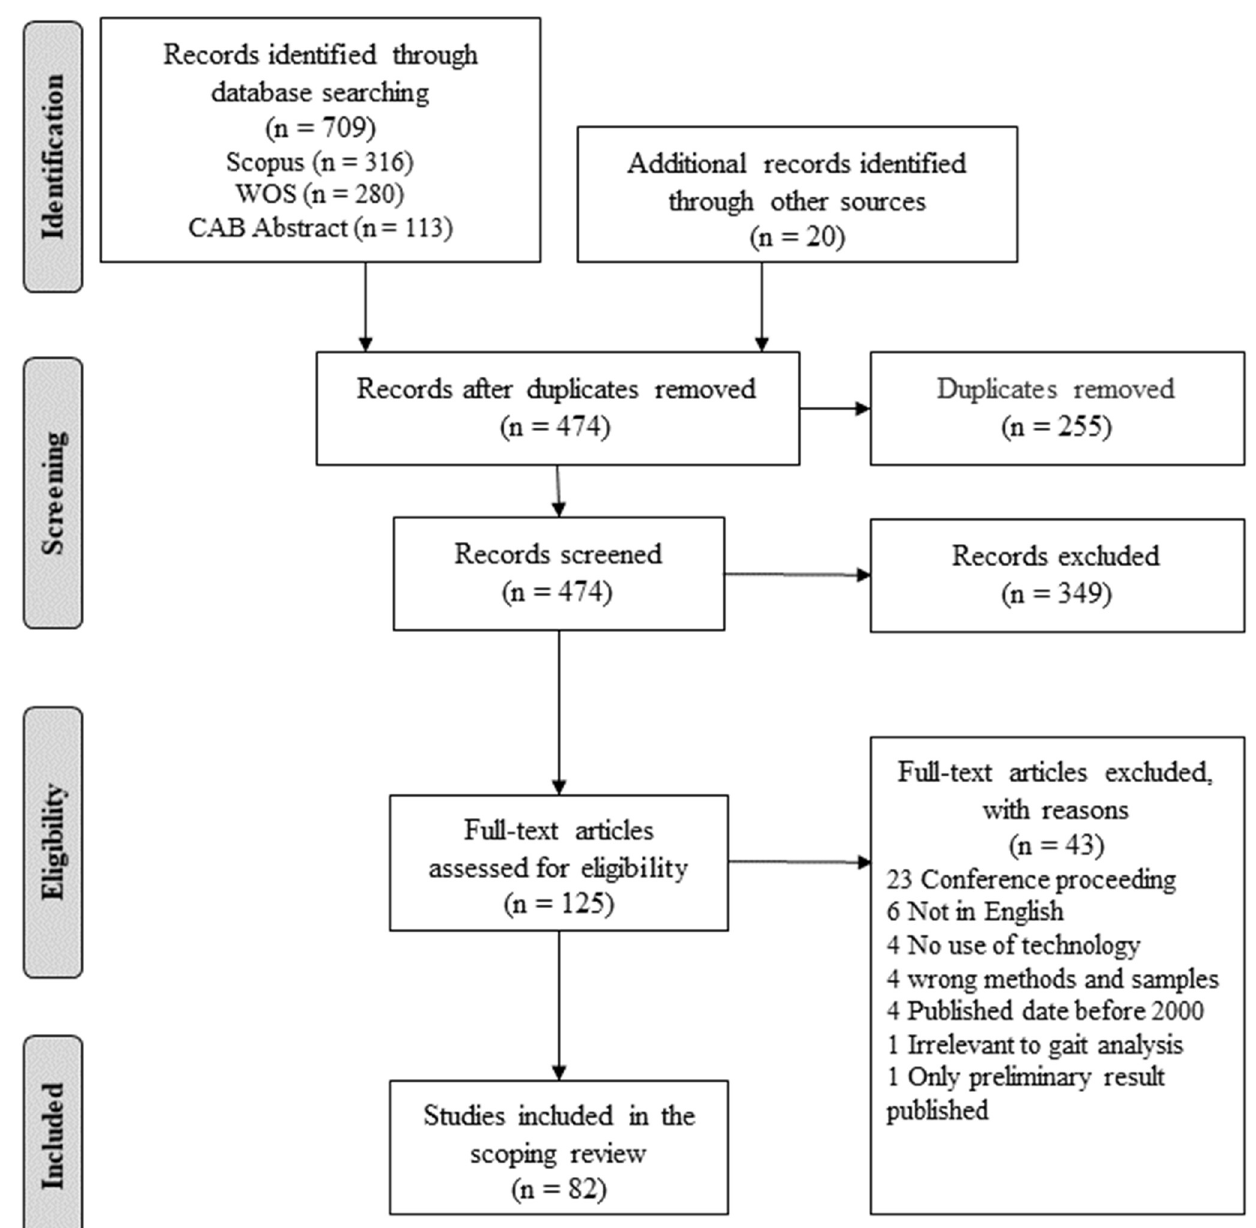
Fig 1. PRISMA flow diagram for scoping reviews showing literature search and selection of